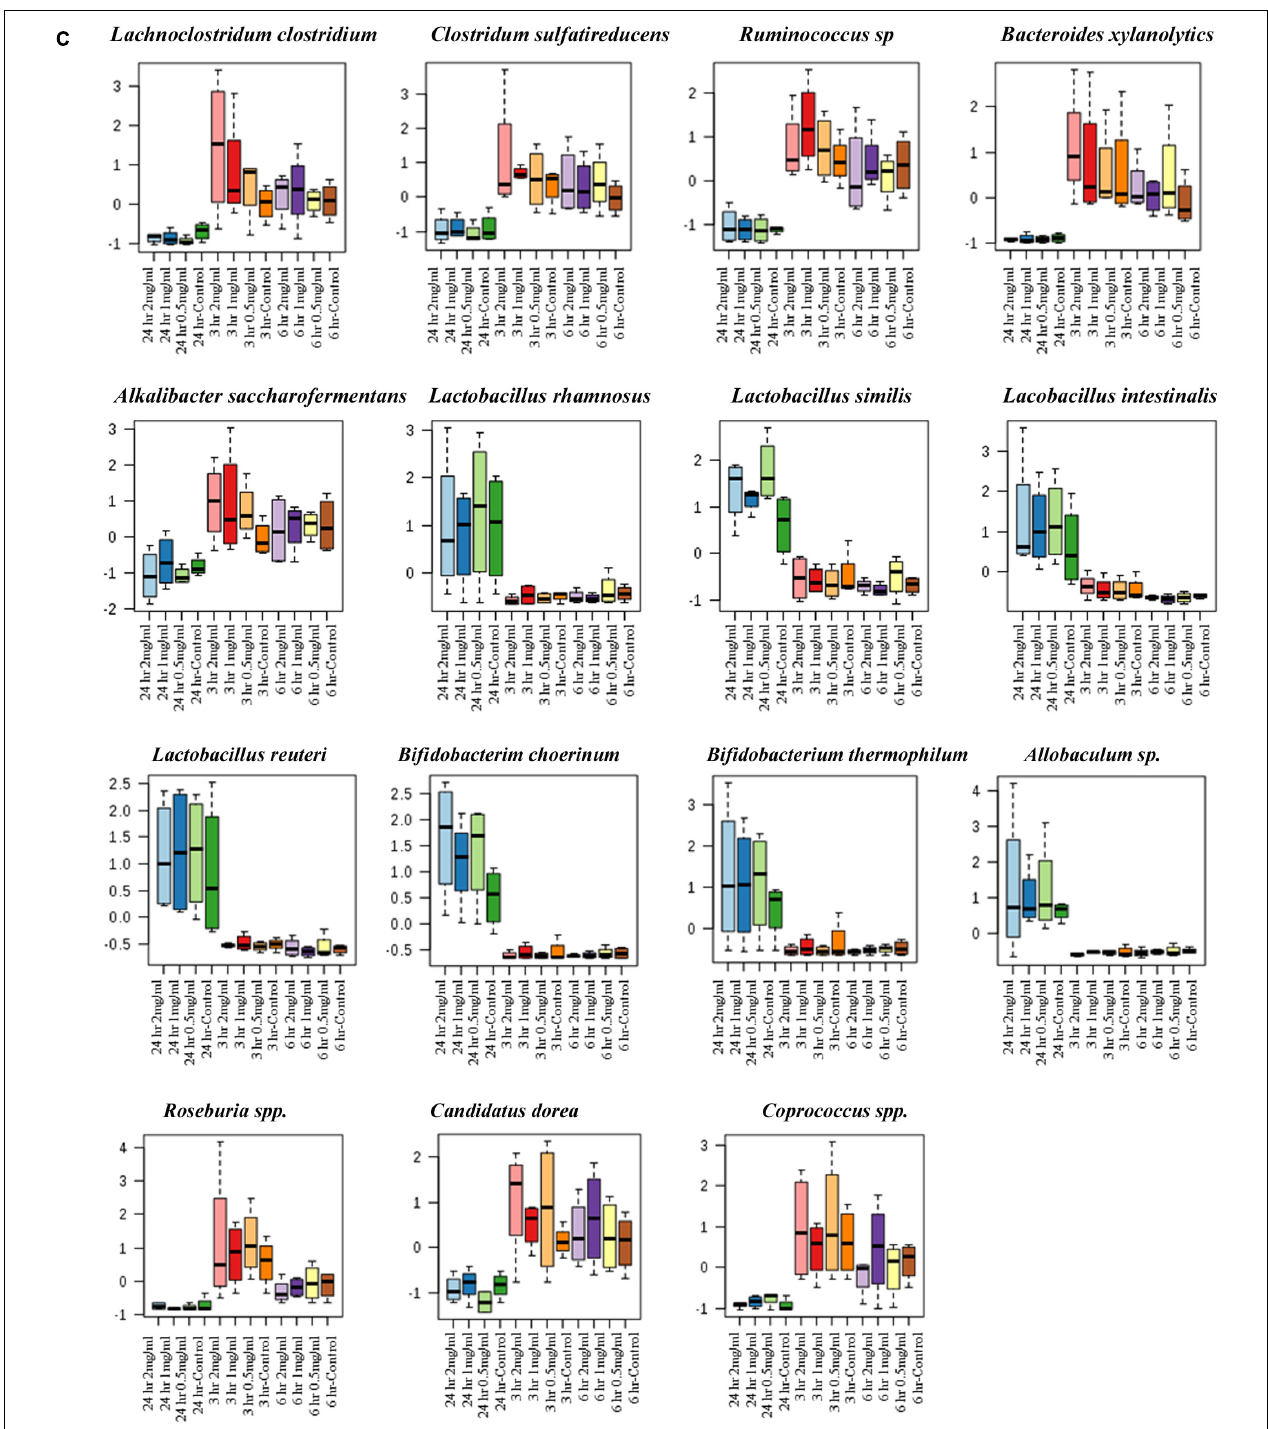
FIGURE 7 | Bacterial community segregation at species level. (A) The PCA plot shows the clear segregation of bacterial community at species level at 24 h time point samples from the other two-time points. Samples collected 3 and 6 h time points are grouped tightly together. The PCA plots also reveal that diversification was more at species level than genera level. (B) Heat map shows the diversity among aloin treated experimental groups. The heat map shows the top 50 bacterial species that altered (either increased or decreased) due to aloin treatment. Here we have shown with red arrow mark of few bacterial species, which were decreased due to aloin treatment. These species are major contributors for butyrate production in the intestine. (C) These figures show that aloin exposure alters the bacterial community increased or decreased abundance at species level. Here we show representative examples for high as well as low abundance on bacterial species due to aloin